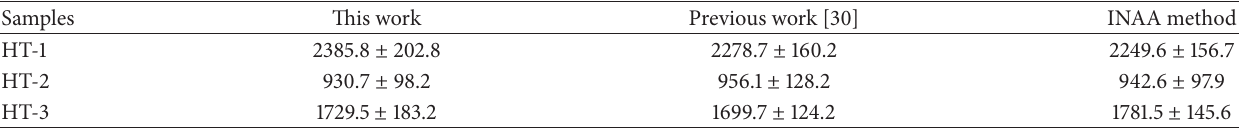
Table 5: The content of thorium in monazite samples